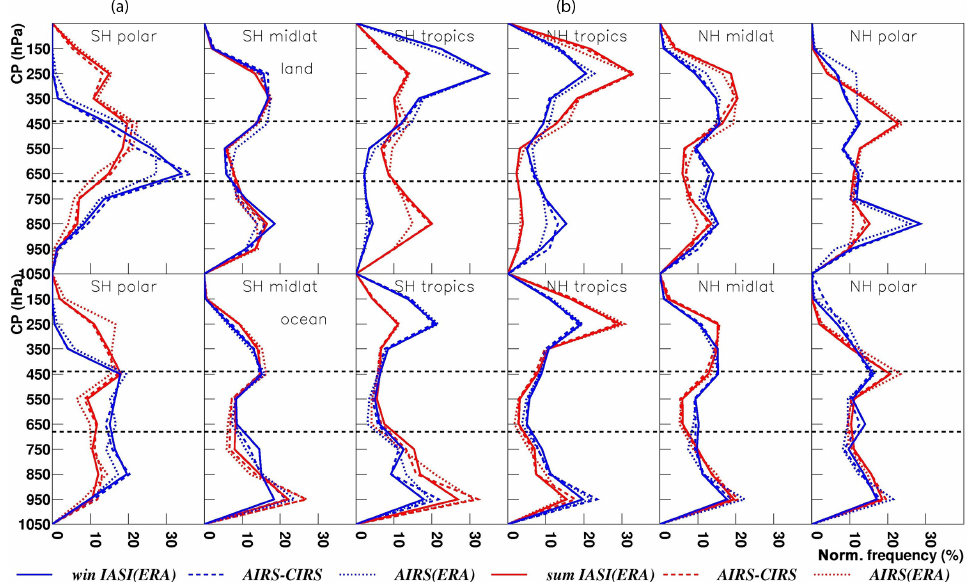
Figure 6. Normalized frequency distributions of p cld , separately over land and over ocean in six latitude bands of 30 ◦ from SH polar (a) to NH polar latitudes (b) , in boreal winter (December, January, February; blue) and in boreal summer (June, July, August; red). Compared are results from AIRS-CIRS using two sets of ancillary data (AIRS-NASA, dashed line) and (ERA-Interim, dotted line), as well as from IASI-CIRS (full line) (statistics from 2008). Table 2. Averages of CA, CAHR, CAMR and CALR (in %) from AIRS-LMD (2003–2009); AIRS-CIRS (2003–2015), using AIRS-NASA and ERA-Interim ancillary data; and IASI-CIRS (2008–2015), using ERA-Interim ancillary